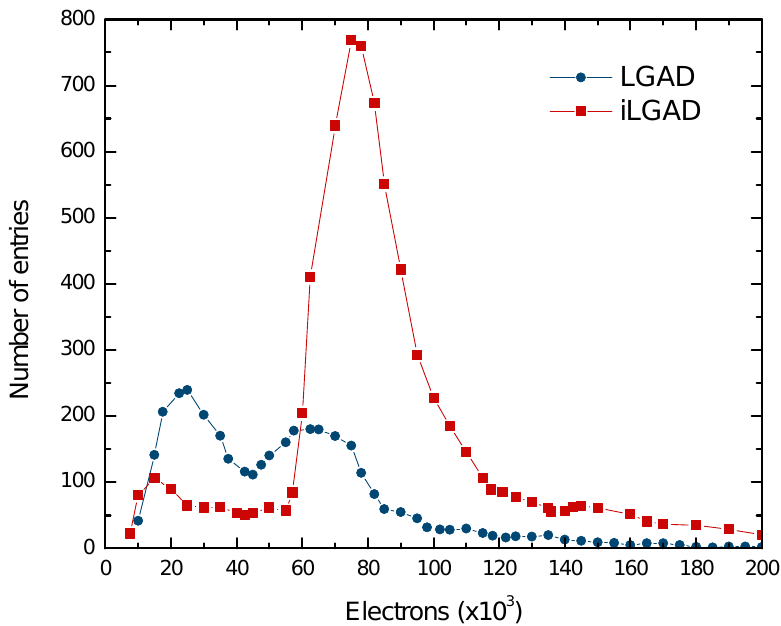
Figure 2. Charge distribution measured during a test beam for one strip LGAD and one strip iLGAD. The iLGAD shows a uniform